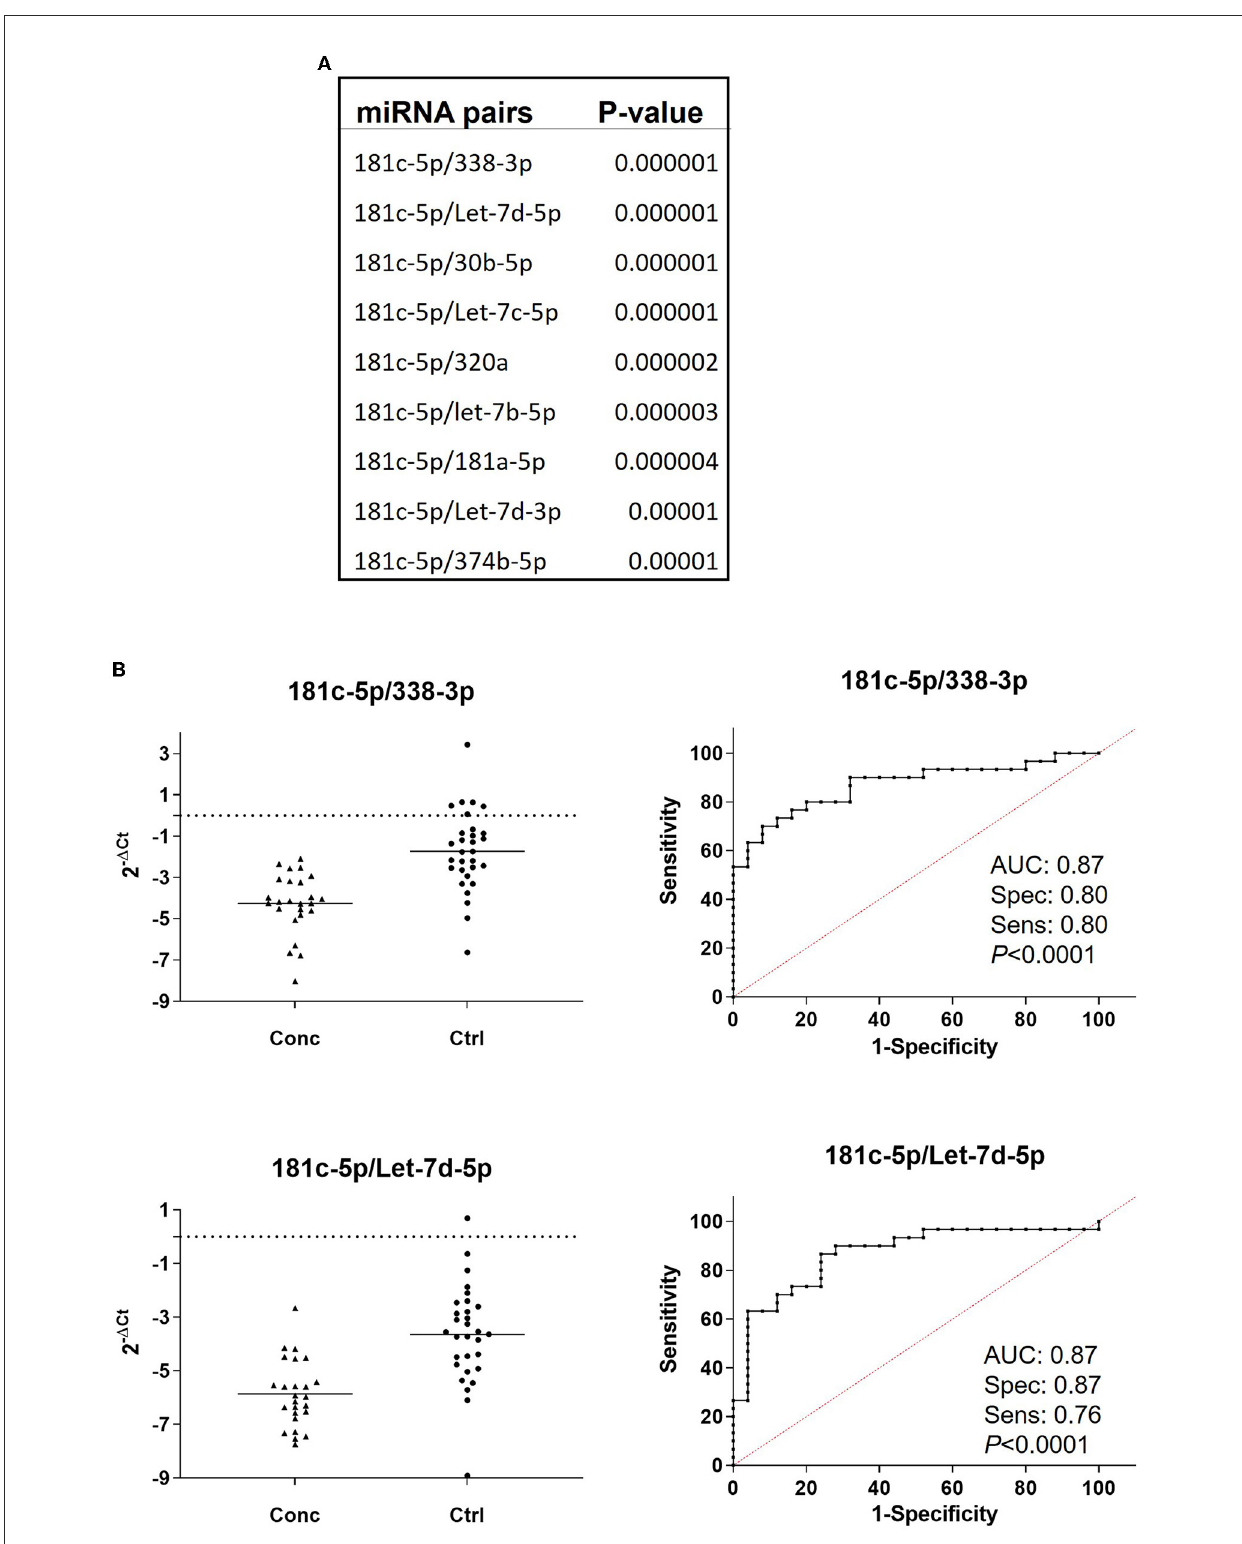
FIGURE4 miRNA pair analysis increases sensitivity and specificity of miRNA biomarkers. (A) List of the miRNA pairs that best discriminate concussed players from controls at all the combined time points (concussed n = 25, controls n = 27). P -values are indicated. (B) Relative expression and ROC curves of the top ranked miRNA pairs, 181c-5p/miR-338-3p and miR-181c-5p/Let-7d-5p. AUC specificity and sensitivity are reported under the